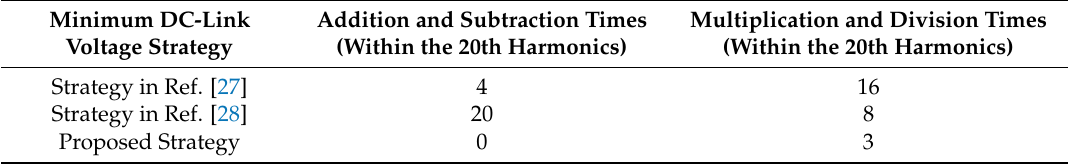
Table 1. Comparison of calculation burden under proposed and conventional strategies.